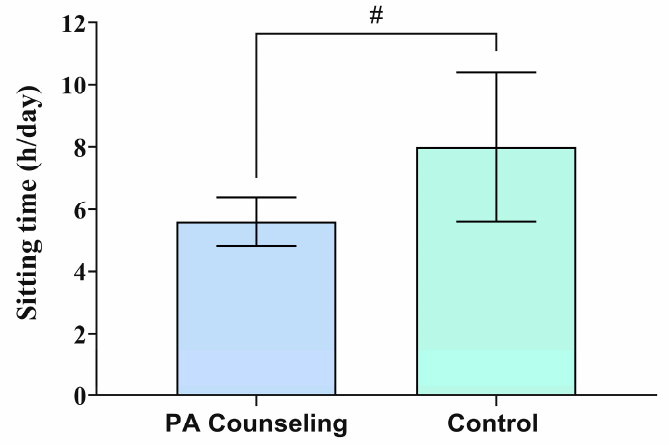
Figure 4. Sitting time of the participants from the physical activity (PA) counseling program group and control group at baseline and after 12 weeks. Data are expressed as estimated marginal means and 95% confidence interval. # Difference from the control group ( p = 0.059) through the generalized linear model with gamma distribution model adjusted by baseline value.